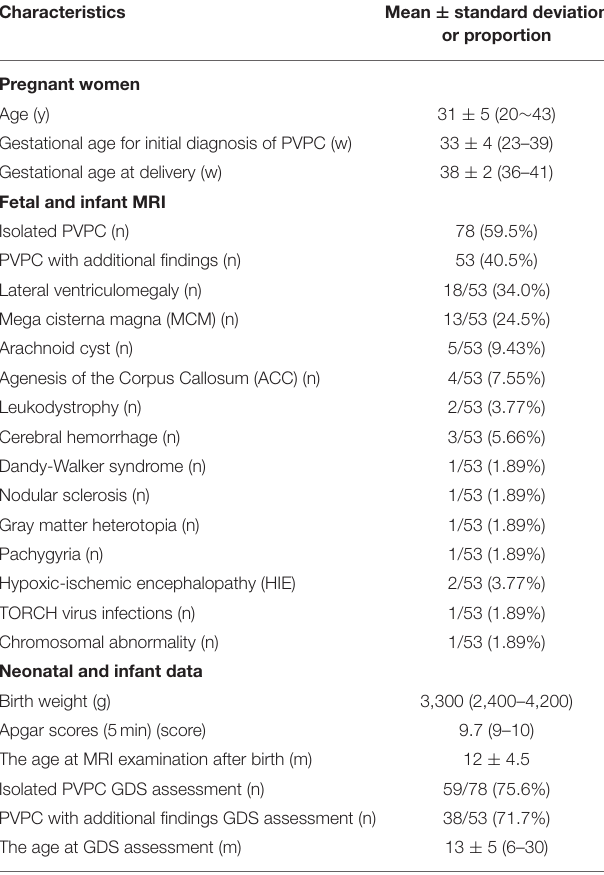
TABLE 1 | Population